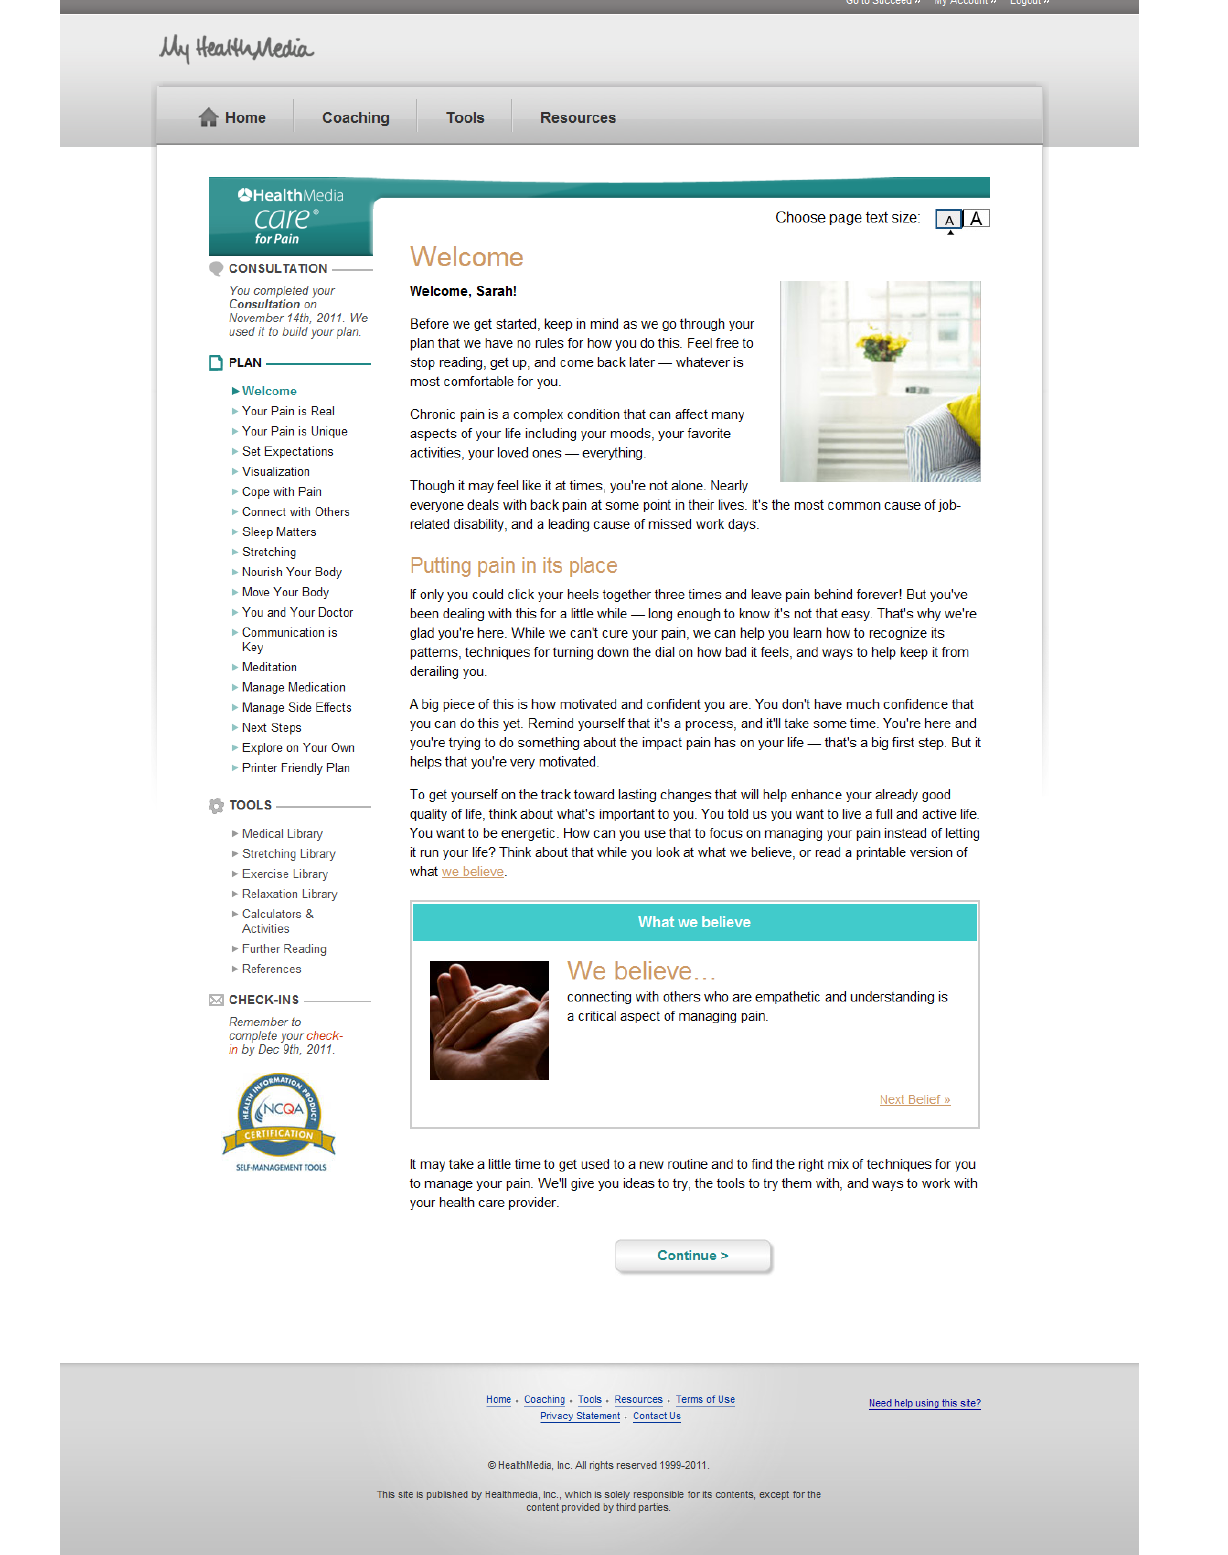
Figure 1. Welcome page of the Web-based pain management